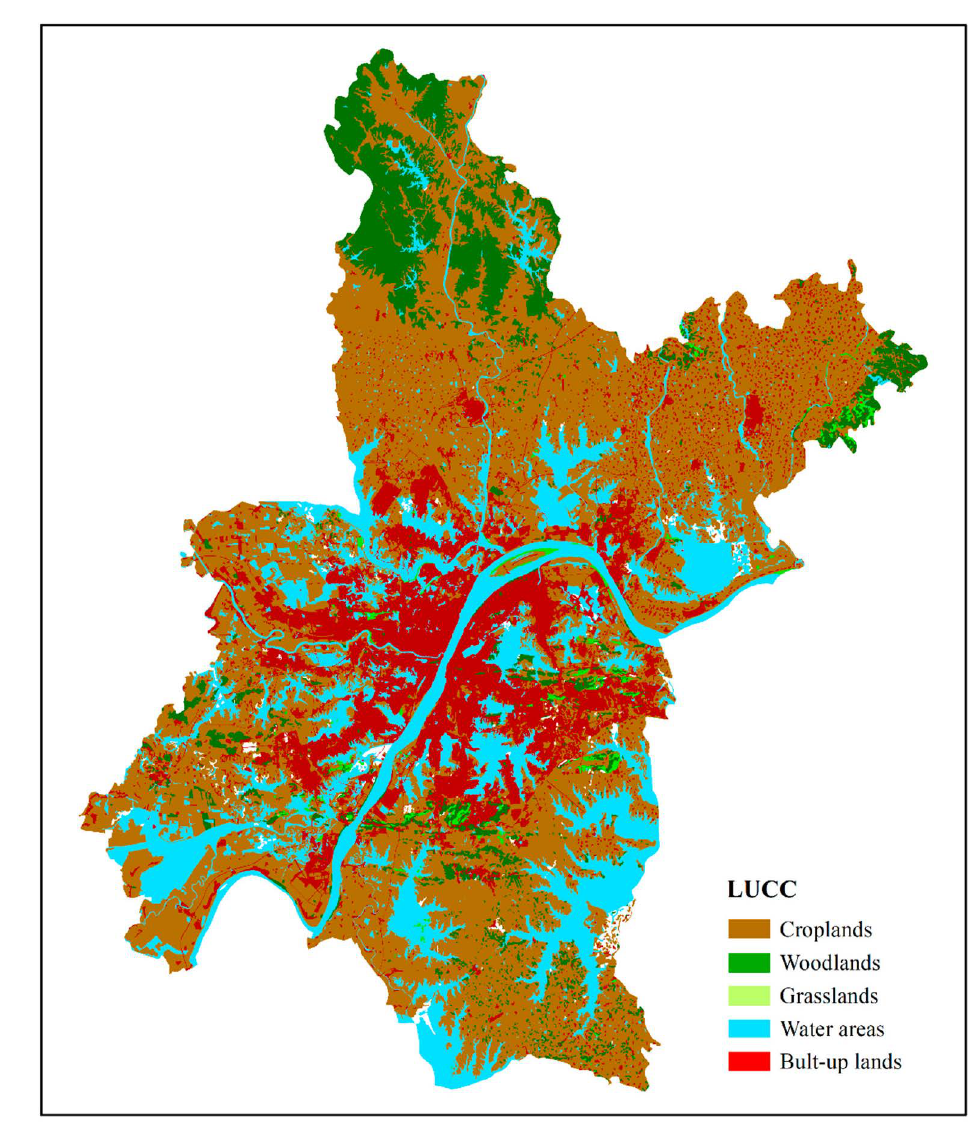
Figure 3. Land-use map of Wuhan in 2019 obtained from